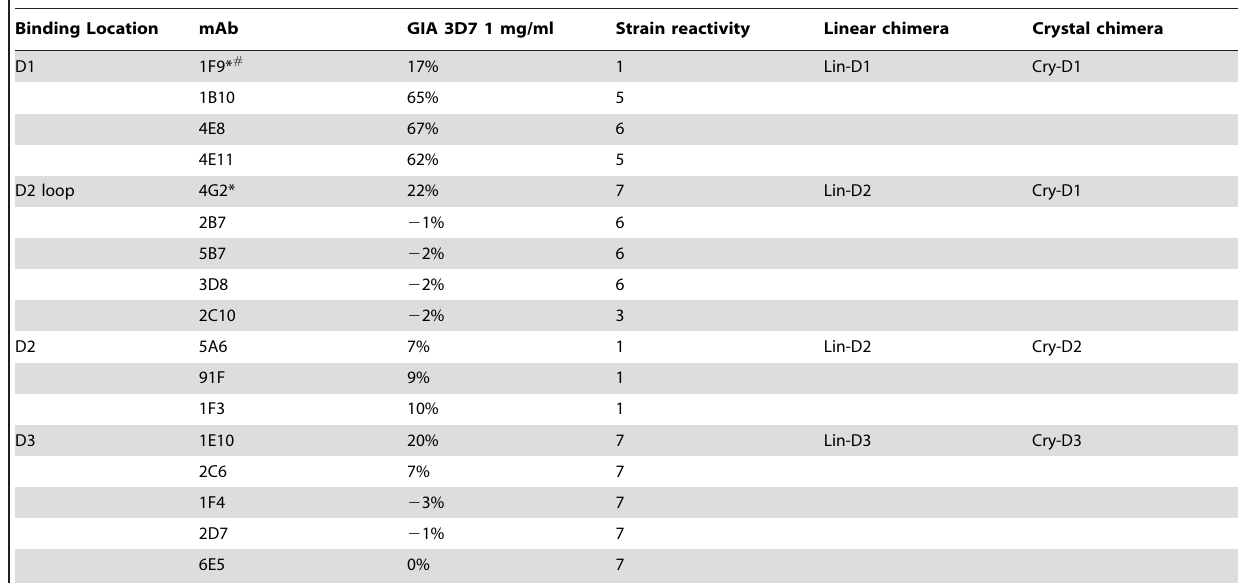
Table 1. Monoclonal antibodies against AMA1.